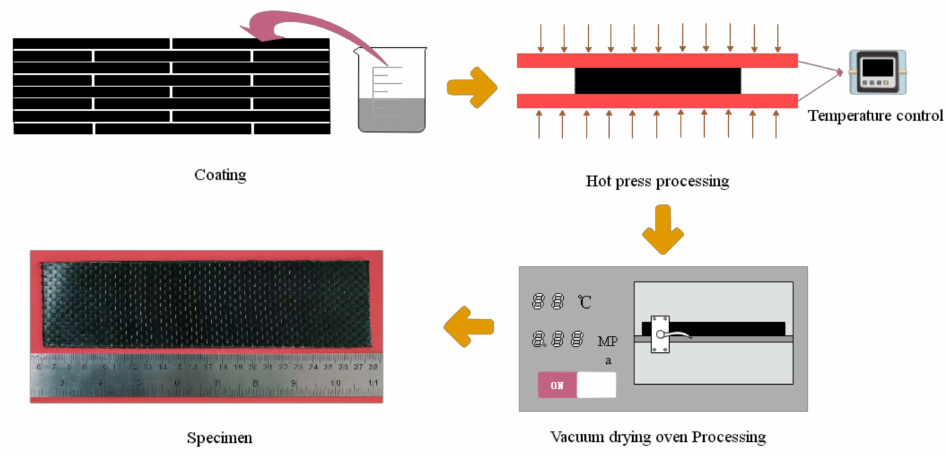
Figure 4. Preparation flow chart of GO-CF/EP composites.